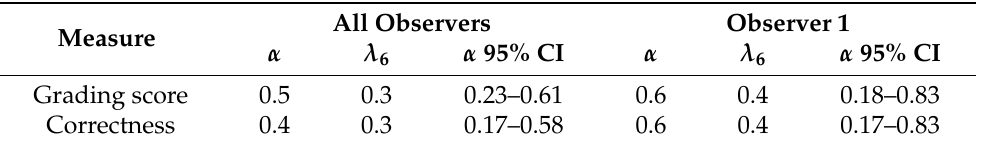
Table 4. Reliability analysis measurements. The table displays values of Cronbach’s α with confidence intervals (CI) and Guttman’s λ 6 for grading score and answer correctness measurements aggregated for all observers in the experiment and the most experienced observer